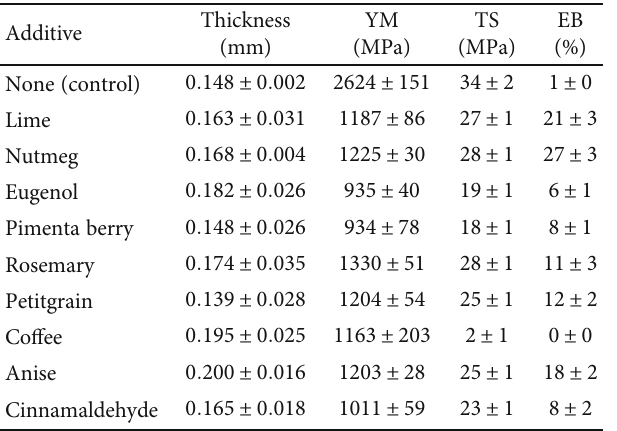
Table 3: Film thickness, Young ’ s modulus, tensile strength, and elongation at break of CAP fi lms incorporated with 20% essential oils.